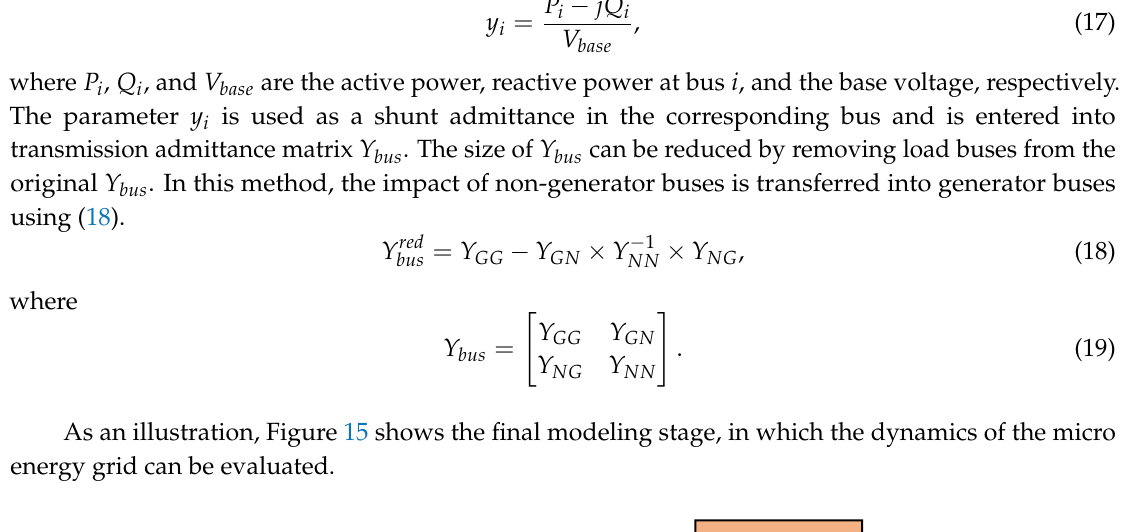
Figure 15. Dynamic Y red